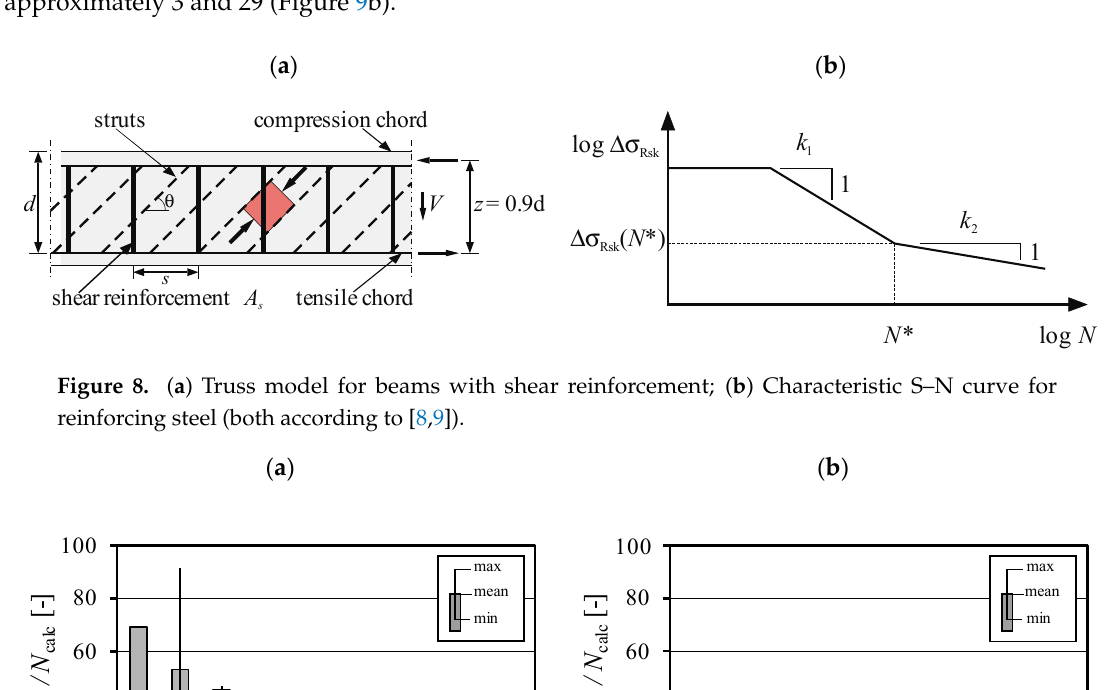
Figure 8. ( a ) Truss model for beams with shear reinforcement; ( b ) Characteristic S–N curve for reinforcing steel (both according to [8,9]).